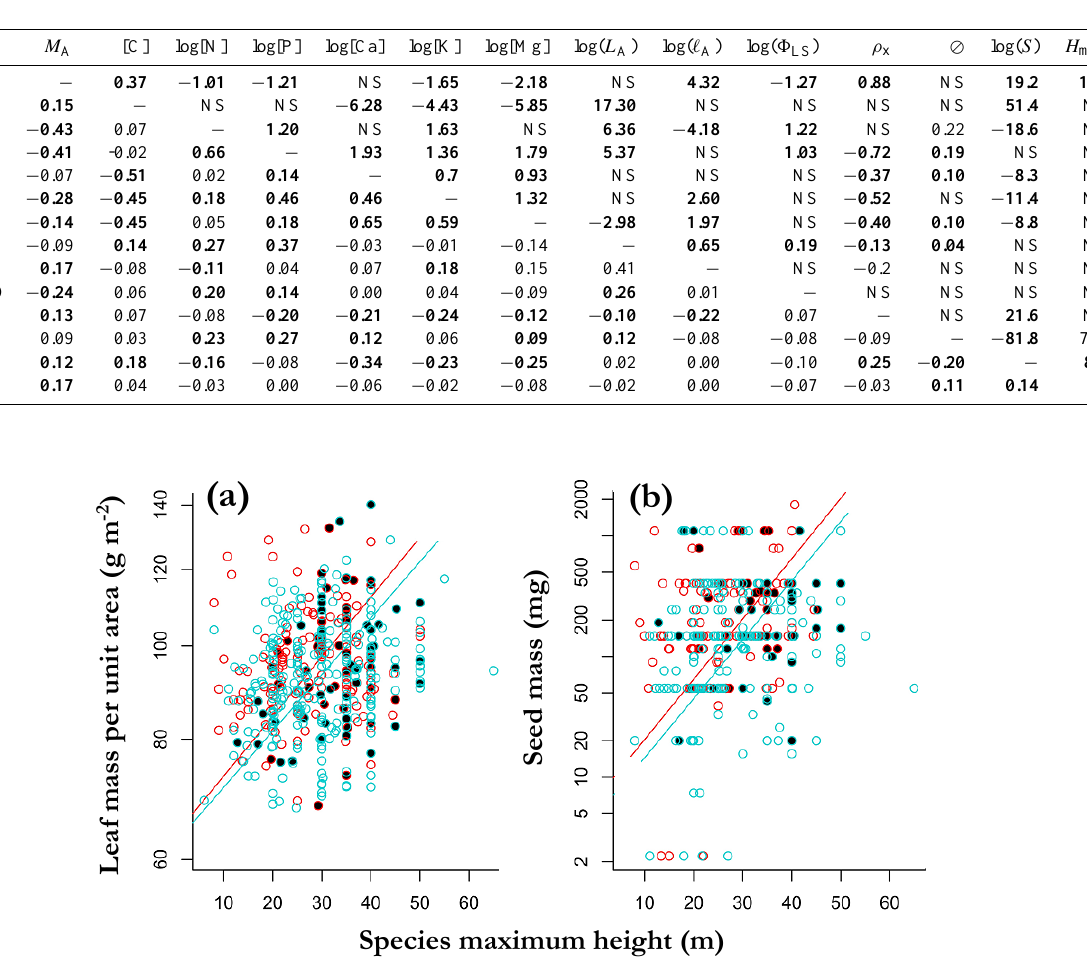
Table 1. Relationships between the derived genetic components of the observed plant traits: M A = leaf mass per unit area (gm − 2 ); elemental concentrations are on a dry weight basis (mgg − 1 ), L A = leaf area (m 2 ), ‘ A = leaflet area (m 2 ), 8 LS = leaf area:sapwood area ratio height (m). Values above the diagonal represent the slope of the relationship (y axis as columns labels, x axis as row labels). Values below the diagonal represent the correlation coefficient. Values significant at P < 0 . 05 are given in bold. NS = no slope estimated as the relationship was not significant.